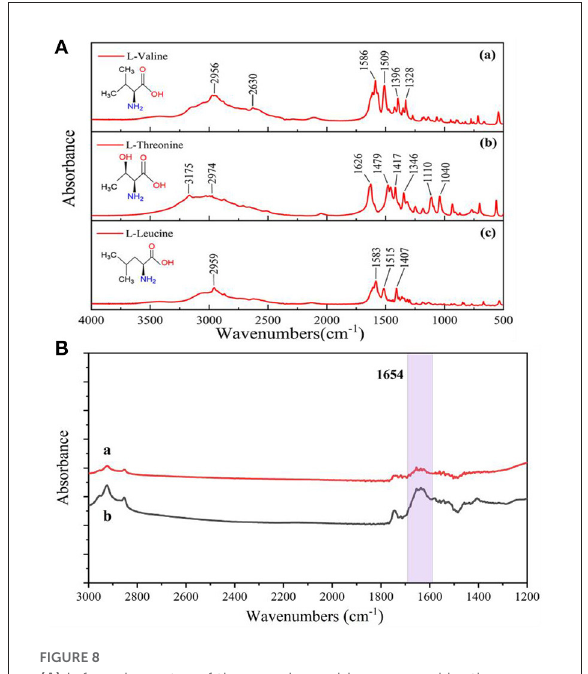
FIGURE8 (A) Infrared spectra of three amino acids measured by the potassium bromide press method, (a) L-valine; (b) L-threonine; (c) L-leucine. (B) Comparison of IR spectra before and after addition of three amino acids to the system, (a) 0.02 mg/mL GSH; (b) 0.02 mg/mL GSH and 0.2 mg/mL (L-leucine, L-threonine,